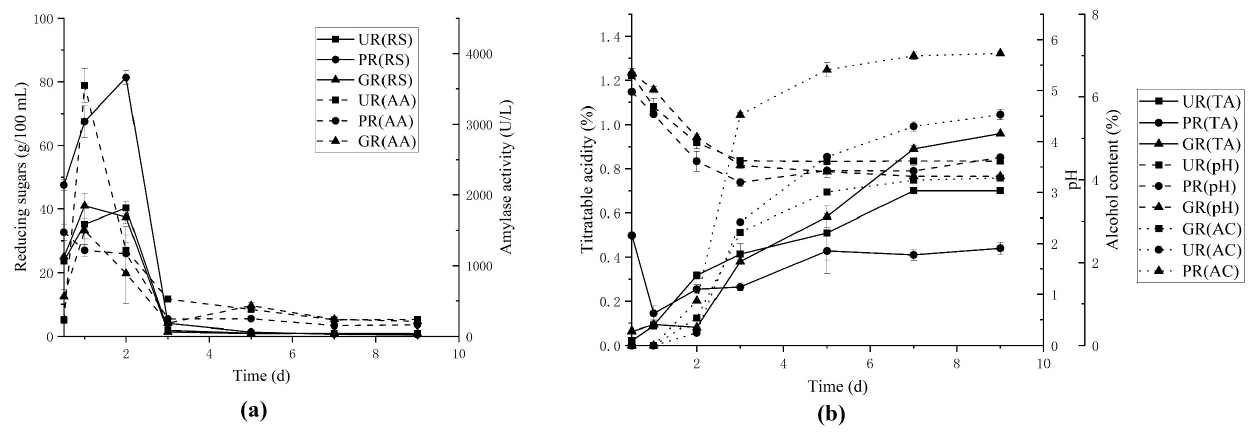
Figure 1. Fermentation traits comparison of three raw materials in brewing MW: ( a ) Comparison of RS contents and AA; ( b ) comparison of AC, TA, and pH value. Abbreviations: PR-polished rice, UR-unhusked rice, GR-germinated rice, RS-reducing sugars, AA-amylase activity, TA-titratable acidity, AC-alcohol content.